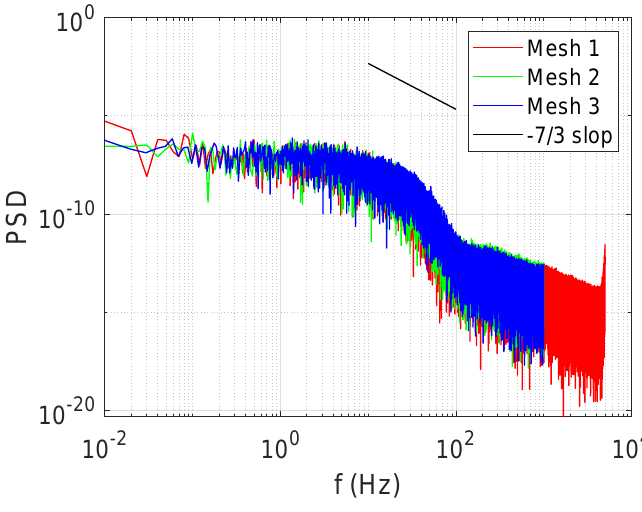
Figure 18. Power spectral density of the pressure fluctuations at one point on the wall at z / D = 2